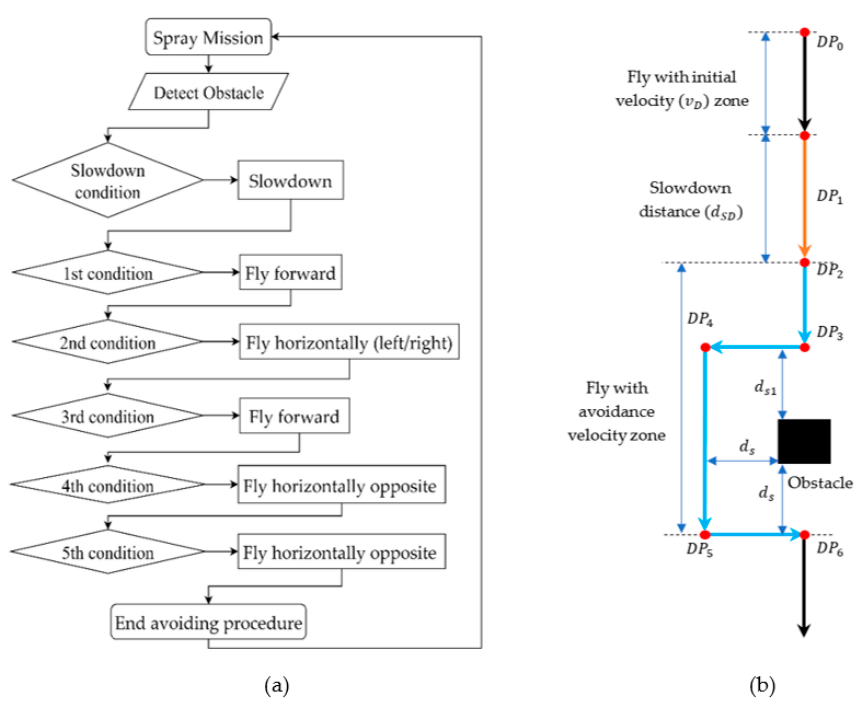
Figure 6. ( a ) High-level path planning flow. ( b ) UAV’s positions in the perspective of an obstacle. DP 0 − 6 are eventual drone